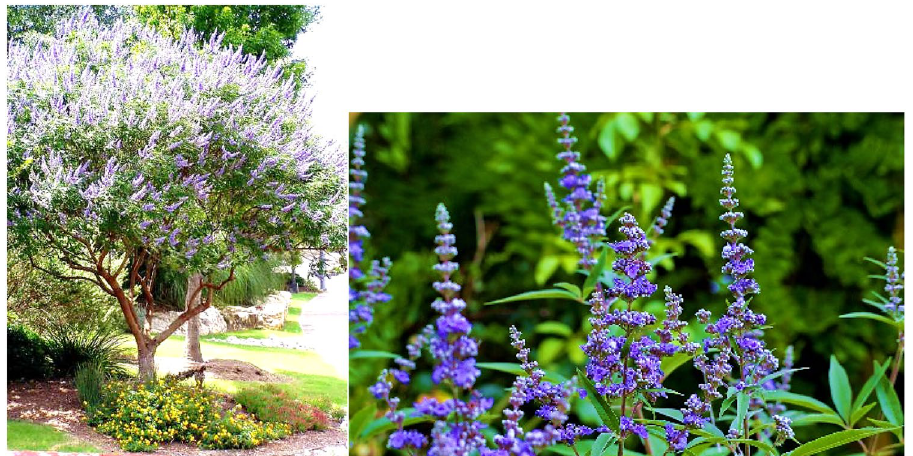
Fig. 1 Images of the Vitagnus